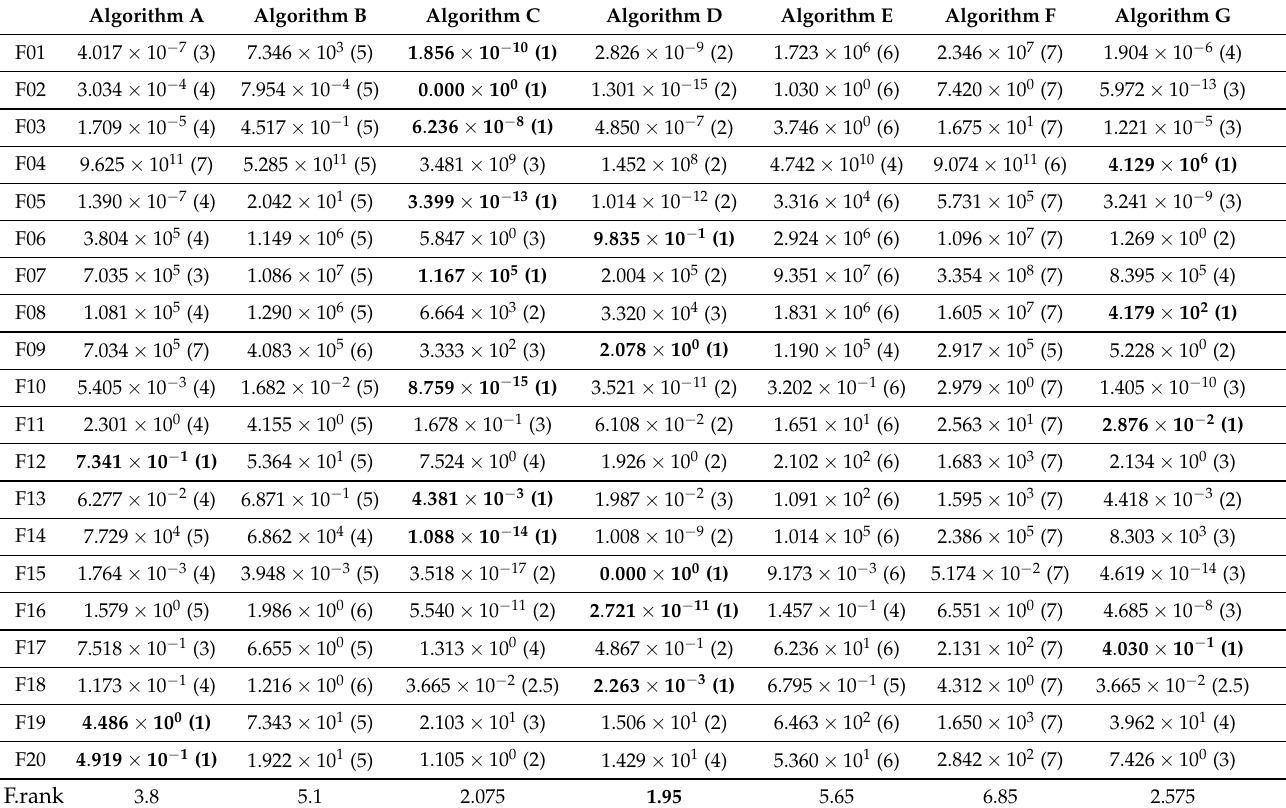
Table 2. Arithmetic mean of solution quality with corresponding rank.